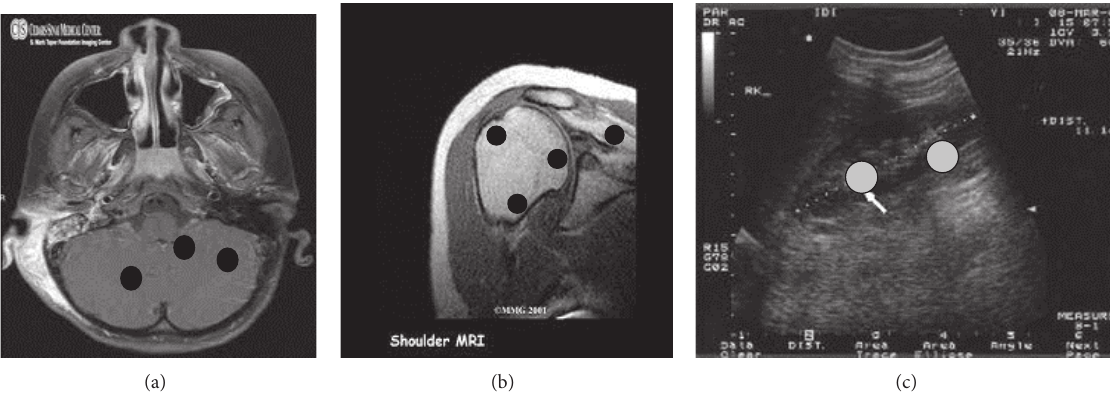
Figure 4: Watermarked medical images (from left to right: CT scan, MRI scan, and ultrasound) with tampers inside ROI.